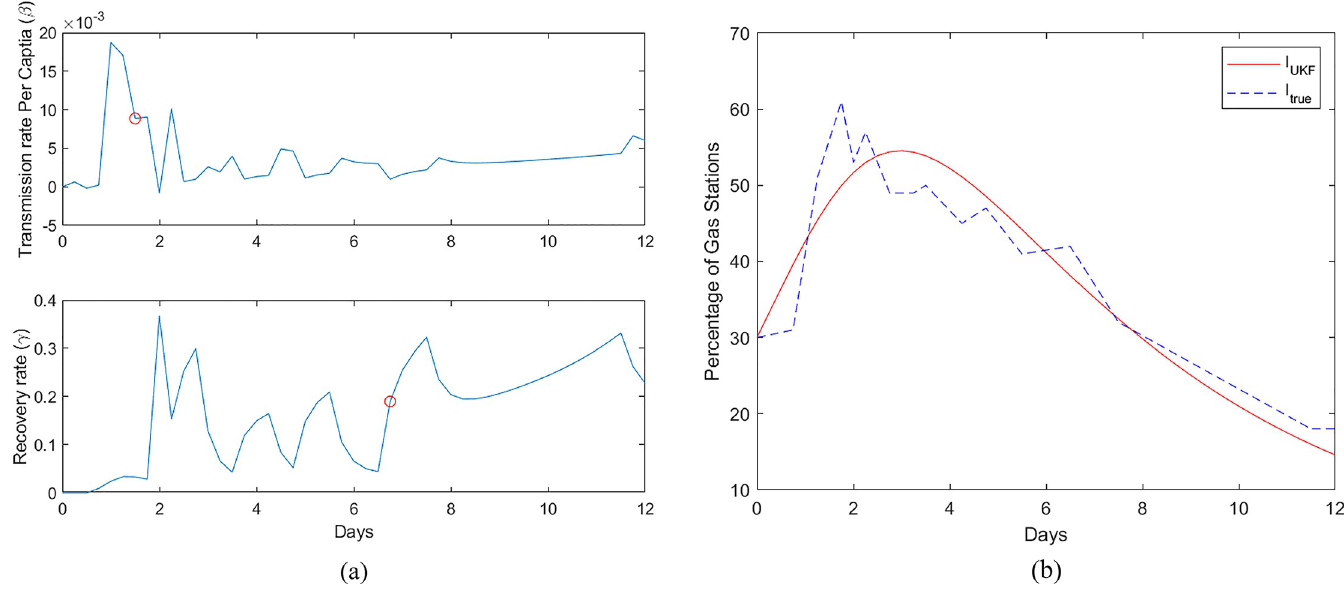
Fig 3. (a). β and γ rates estimated from Gasbuddy data for each time step (dt) for Fort Myers-Naples during Hurricane Irma. The red circle represents the β and γ values used to plot I UKF in 3(b). (b) Continuous time Invariant data of % empty fuel stations (I(t)). Computed data from the best fit β and γ constant parameters, and the empirical data is shown for Fort Myers-Naples during Hurricane